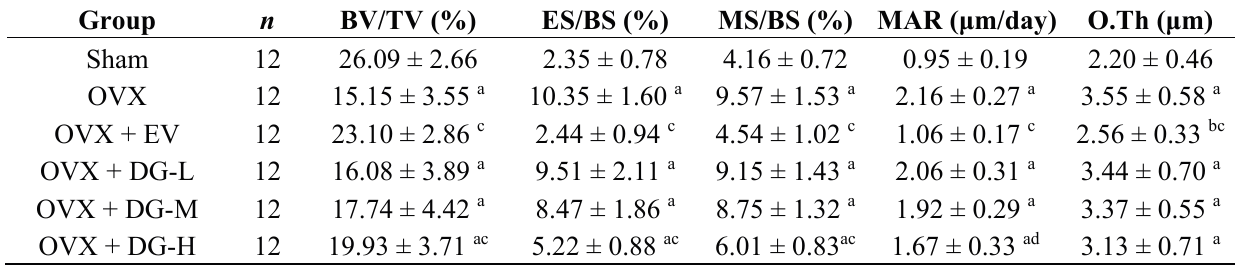
Table 2. Comparison of indices of bone histomorphometry among